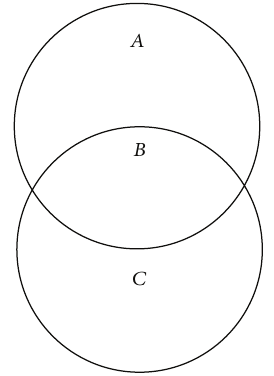
Figure 3: The partition of the Dunwoody (1,1)